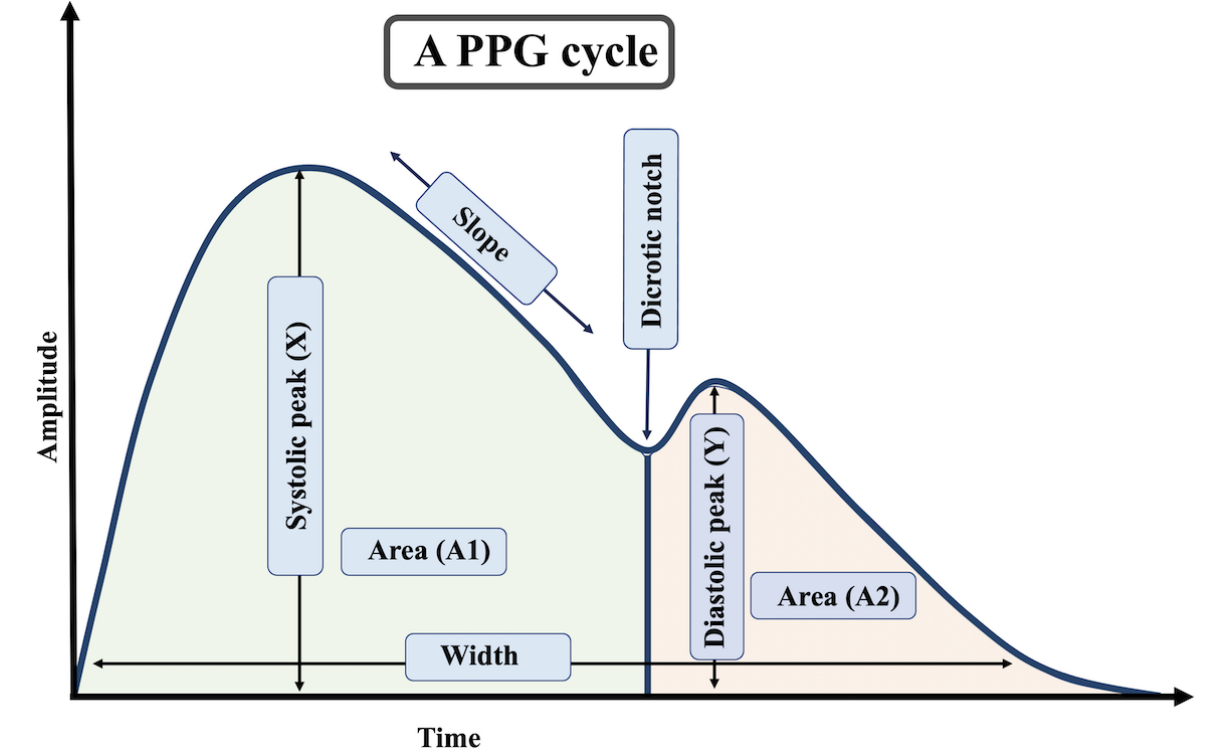
Figure 6. Multiple features collection from a photoplethysmogram